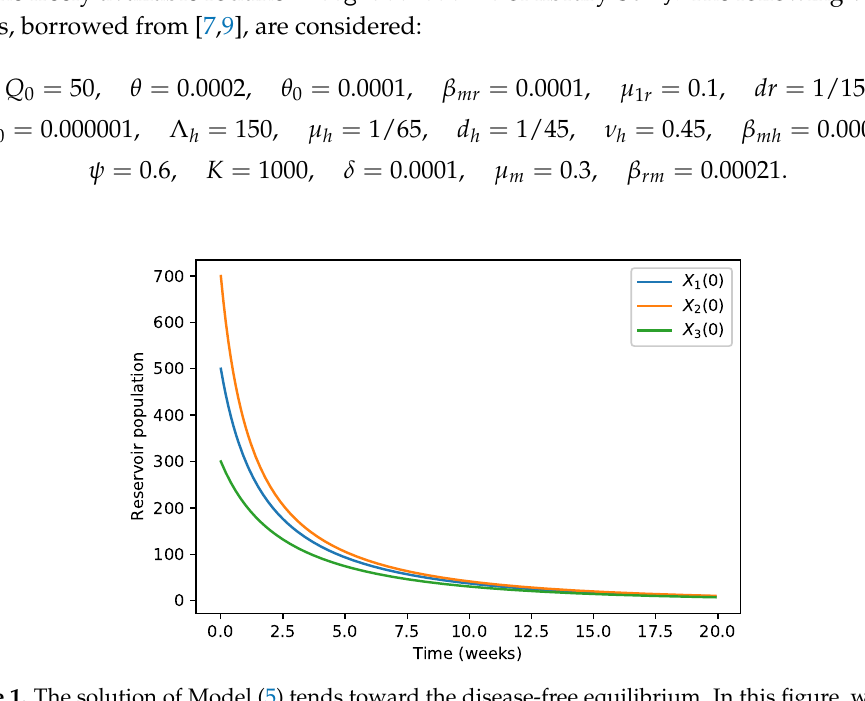
Figure 1. The solution of Model (5) tends toward the disease-free equilibrium. In this figure, we show the evolution of the infected animals population for different initial